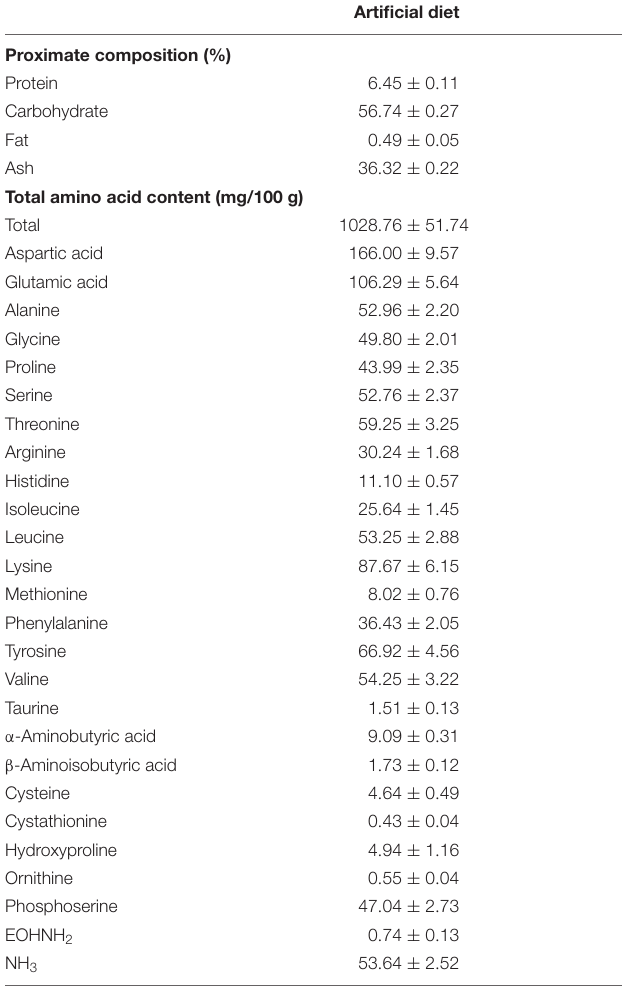
TABLE 1 | Proximate composition (% in dry weight) and total amino acid contents (mg/100 g in wet weight) (mean ± SE) in the artificial diet without amino acid supplementation (control diet) ( n =